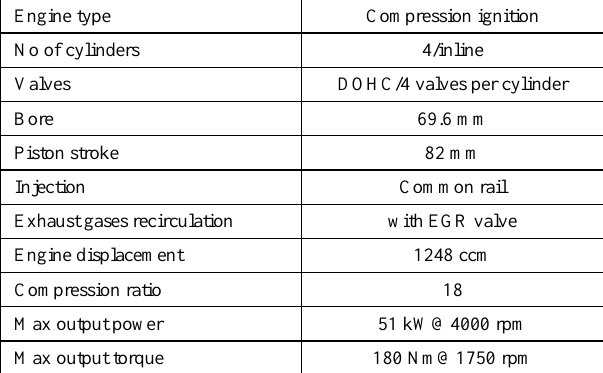
Table 6. Description of engine used for testing